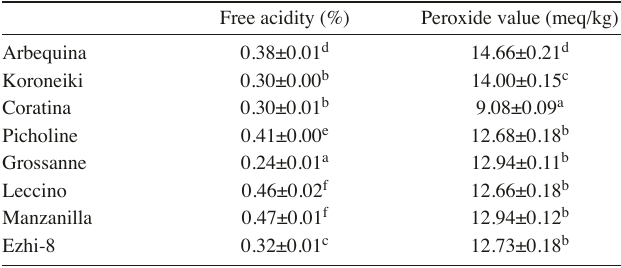
Tab. 3: Free acidity and peroxide value of olive oil